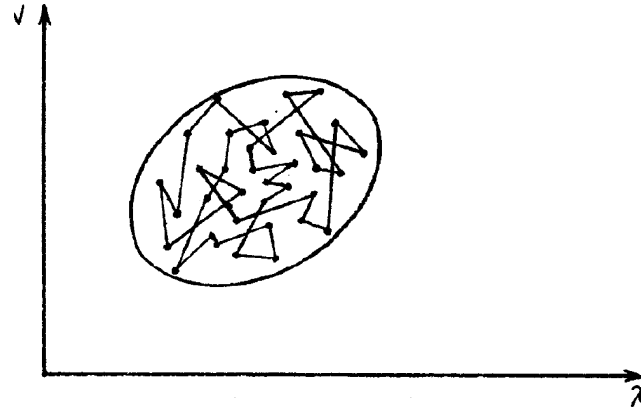
Fig.4. Domain of combinations dispersion of CBF and SV indicators in steady